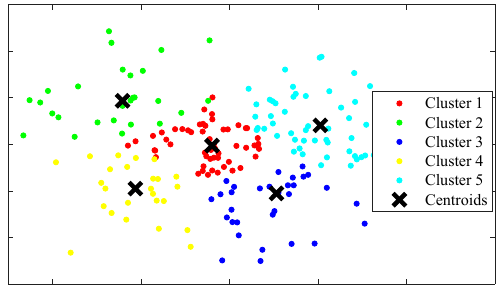
Figure 5. Simulation diagram of cluster partition.